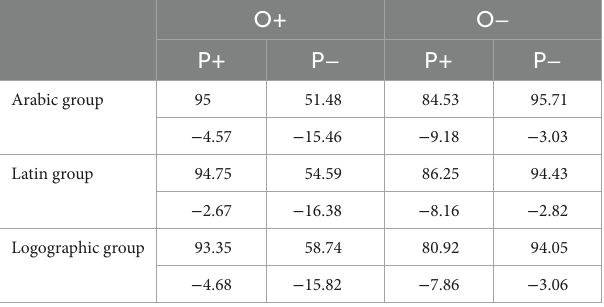
TABLE 4 By-item accuracy (%) means and standard